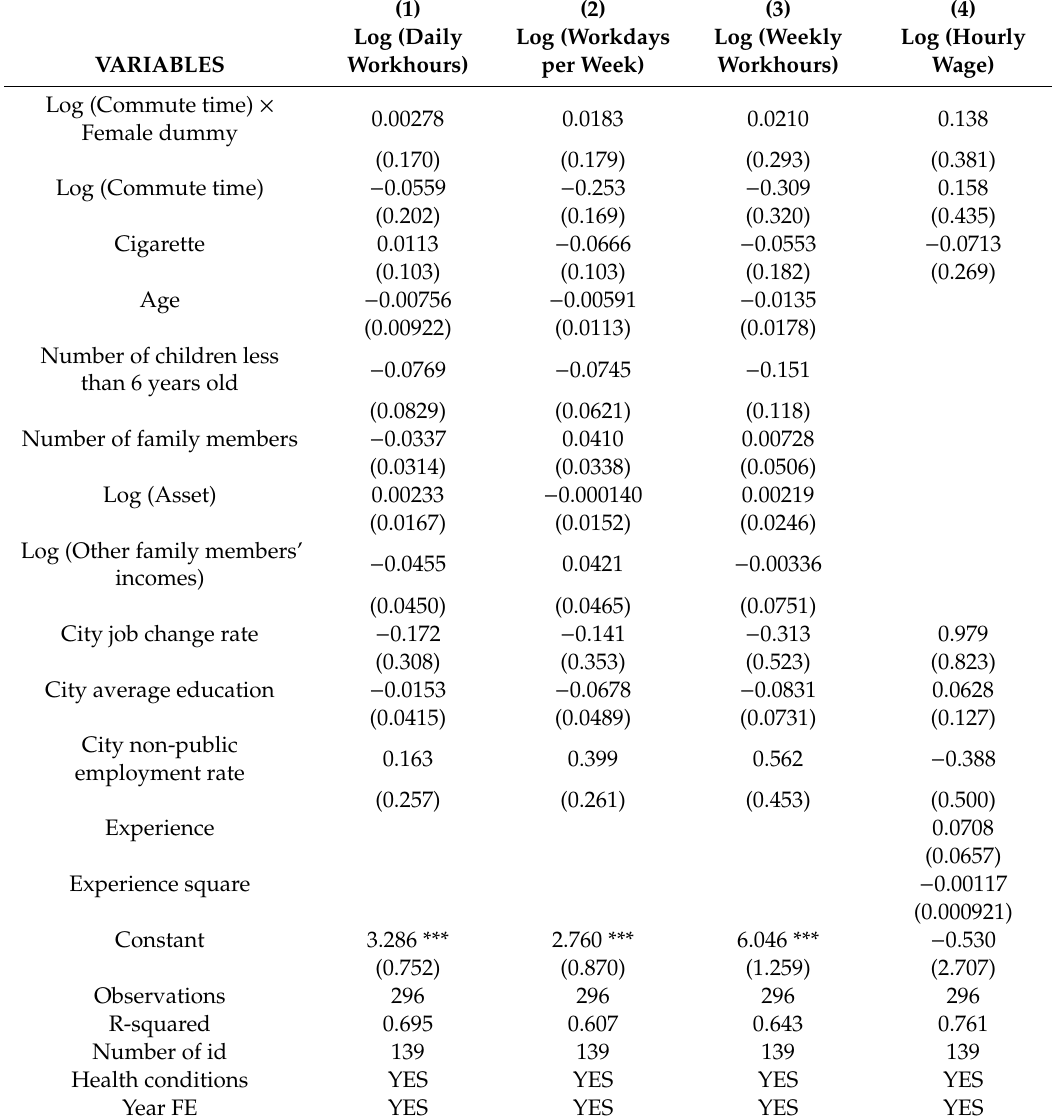
Table 9. Labor supply and wage for job changed workers based on